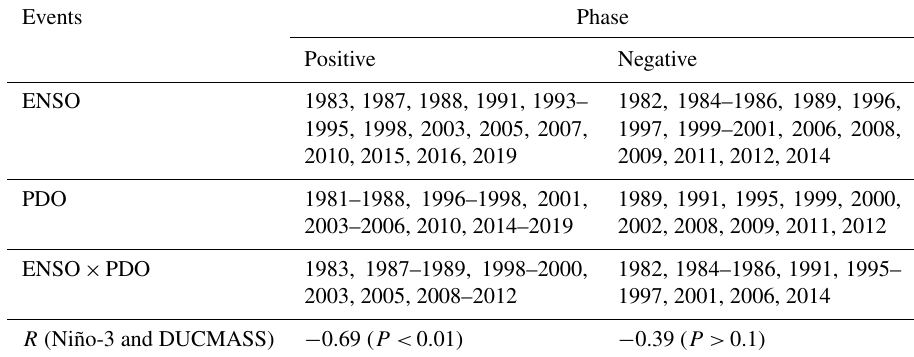
Table 2. List of individual and combined wintertime ENSO–PDO years during 1982–2014.